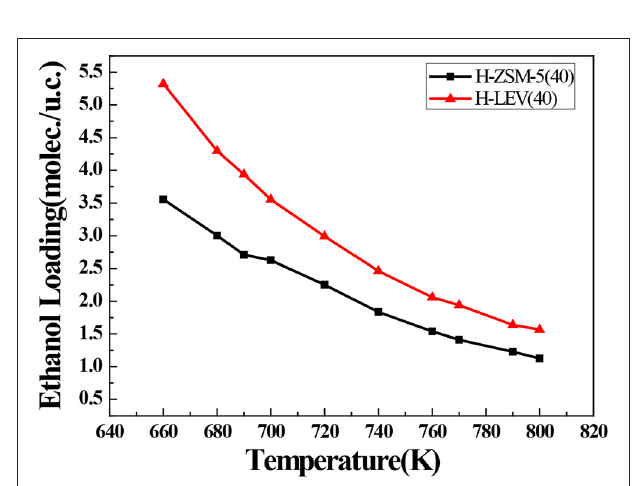
FIGURE 4 | Ethanol adsorption amounts in H-ZSM-5 (40) and H-LEV (40) with different temperatures under 100